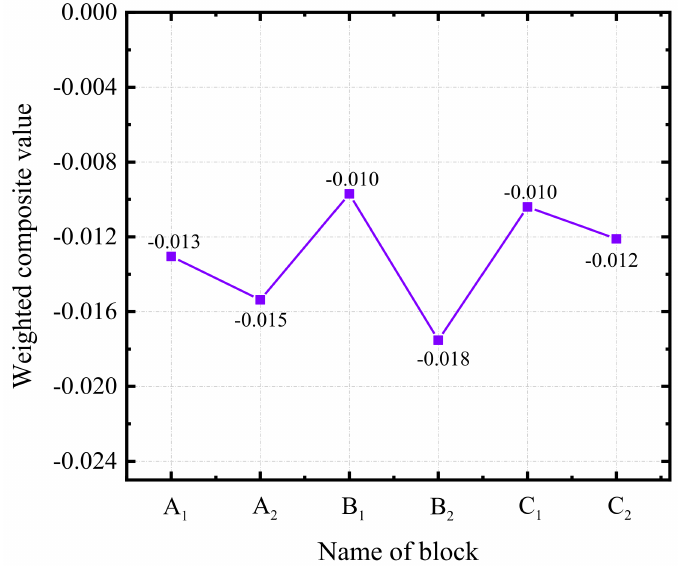
Figure 14. Weighted comprehensive value of each